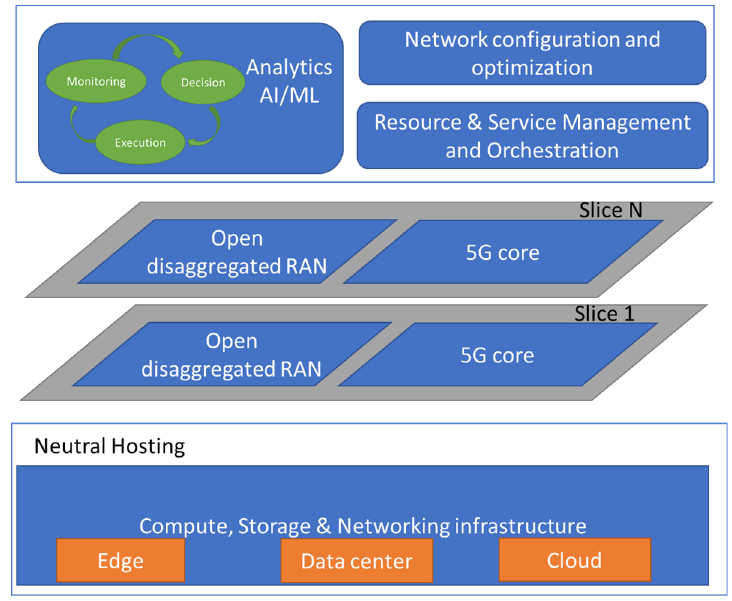
Figure 1. Conceptual approach of our proposed approach.